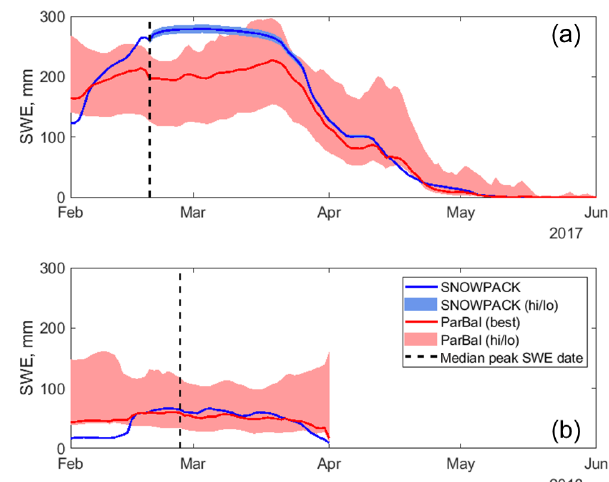
Figure 4. Mean SWE for 2017 (a) and 2018 (b) modeled at all of the AKAH stations using SNOWPACK (blue lines) compared to reconstructed SWE from ParBal using a best-of-9-pixel approach (red lines). Also plotted is the median peak SWE date. The high– low (hi/lo) bounds (filled areas) represent uncertainty. For ParBal, uncertainty is expressed as the range of values in the 9-pixel neigh- borhood. For SNOWPACK, uncertainty is 5% of the modeled SWE during the ablation season. See Sect. 5.1 and 5.2 for details. The modeled SWE values end abruptly on 1 April 2018 because the AKAH stations stopped reporting due to drought conditions. The number of stations used is the same as in Fig.